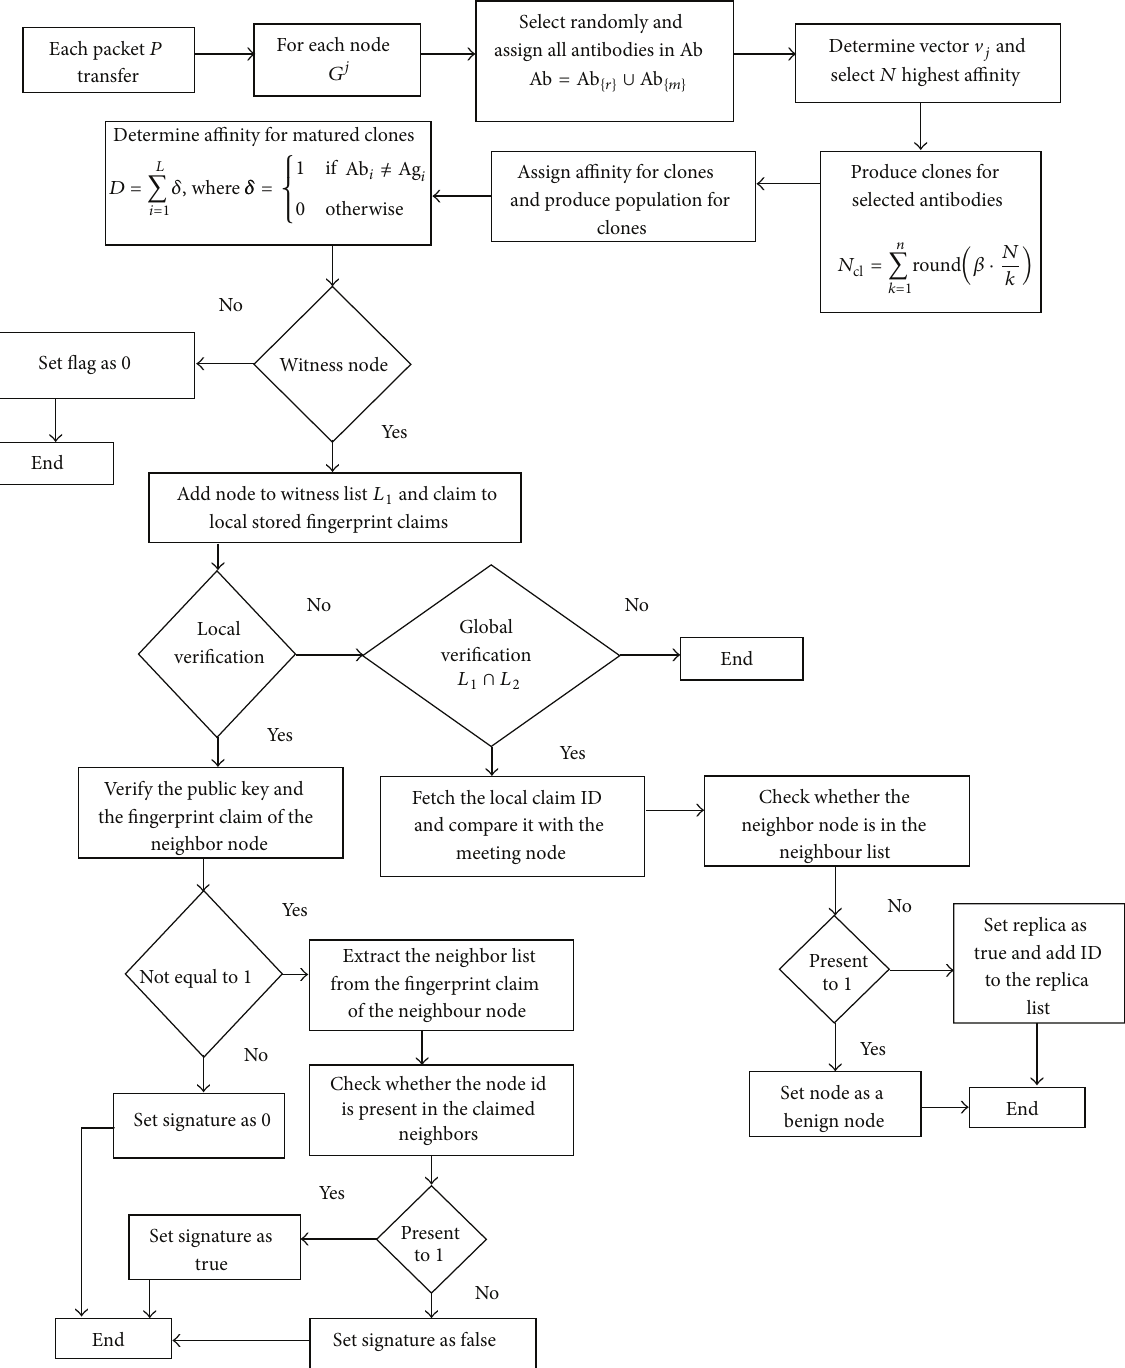
Figure 2: Flow diagram of the proposed CSSHD